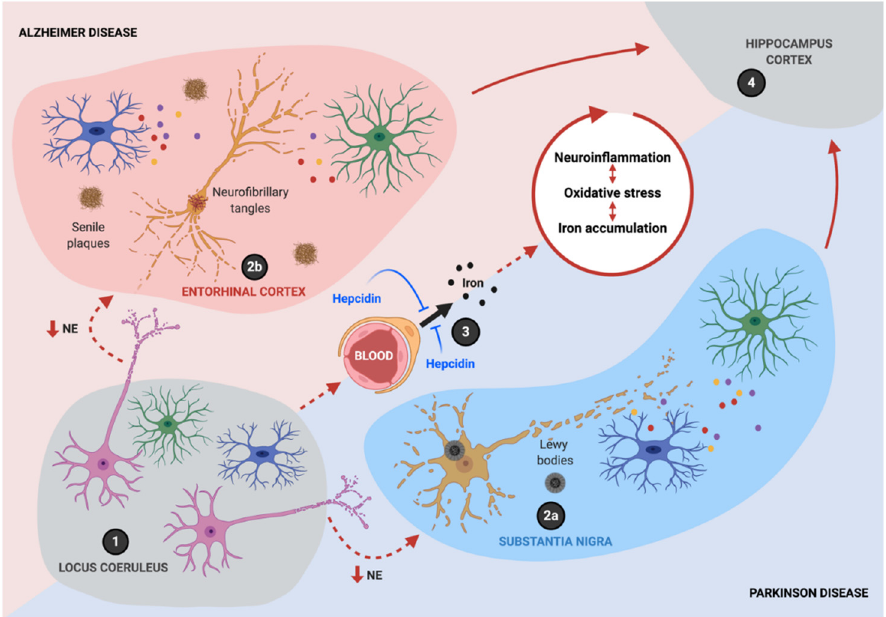
Figure 4. Iron and inflammation are intertwined in a bidirectional relationship during neurodegen- eration. The neurodegenerative process starts with the loss of immune homeostatic mechanisms, partially due to decreased norepinephrine (NE) neurotransmission after the degeneration of the locus coeruleus (LC) (1). It continues with neuronal death in intrinsically sensitive areas, such as the substantia nigra (SN) (2a) and the entorhinal cortex (2b), fueled by a positive feedback loop between neuroinflammation, oxidative stress, and iron accumulation (the wheel at the center). As the disease progresses, neurodegeneration continues to other brain regions, such as the hippocampus and the cortex (4). Hepcidin can suppress the main pathologies in experimental Alzheimer’s disease (AD) and Parkinson’s disease (PD) through the inhibition of iron entry at the blood–brain barrier (BBB) (3). Created with